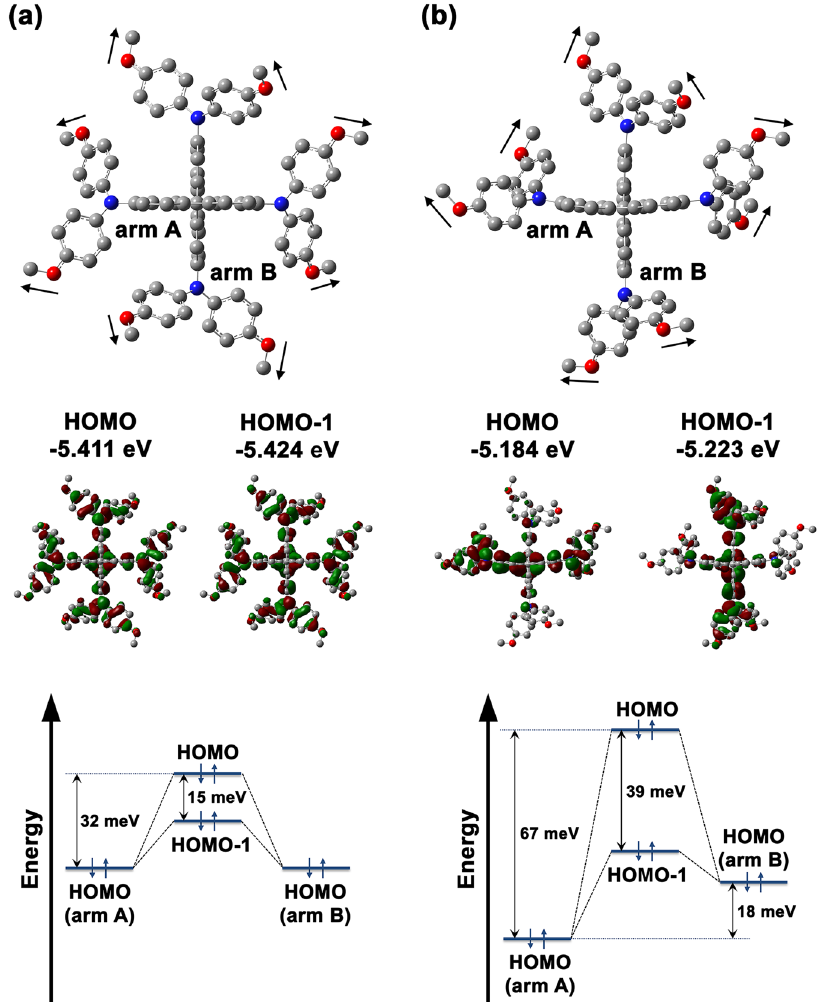
Fig. 2 Comparison of the molecular geometry, DFT (Opt- ω B97X-D/6-31 G**)-estimated wave functions and energy levels of HOMO and HOMO-1, and DFT ( ω B97X/TZ2P)-estimated interaction between the fragment HOMOs of the two arms for: a an ideal spiro-OMeTAD molecule in gas phase; and b a molecule extracted from the spiro-OMeTAD crystal. The arrows in the top panels denote the orientation of the methoxy groups. All the molecules are in their neutral ground